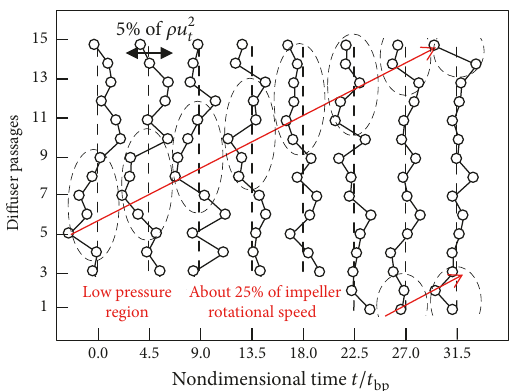
Figure 7: Casing static pressure fluctuations at diffuser inlet from nondimensional time 𝑡 ∗ = 0.0 to 𝑡 ∗ = 31.5 (CFD).